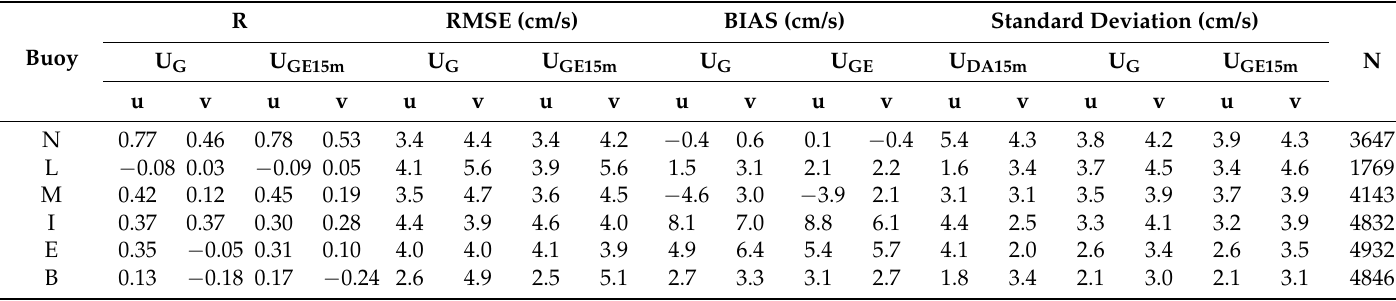
Table 2. Summary of GoM region statistical measure comparisons between components (eastward u and northward v) of in situ ADCP depth-averaged current velocities U DA15m and either GlobCurrent U G (Geostrophic only) or U GE15m (Geostrophic + 15 m Ekman) data. Also shown are standard deviations of these components for U DA15m , U G , and U GE15m . Analysis time periods differ for the separate buoy sites N, L, M, I, E and B, all exceeding 10 years except for site L. All data were low pass filtered with a 70-days running mean. N is number of